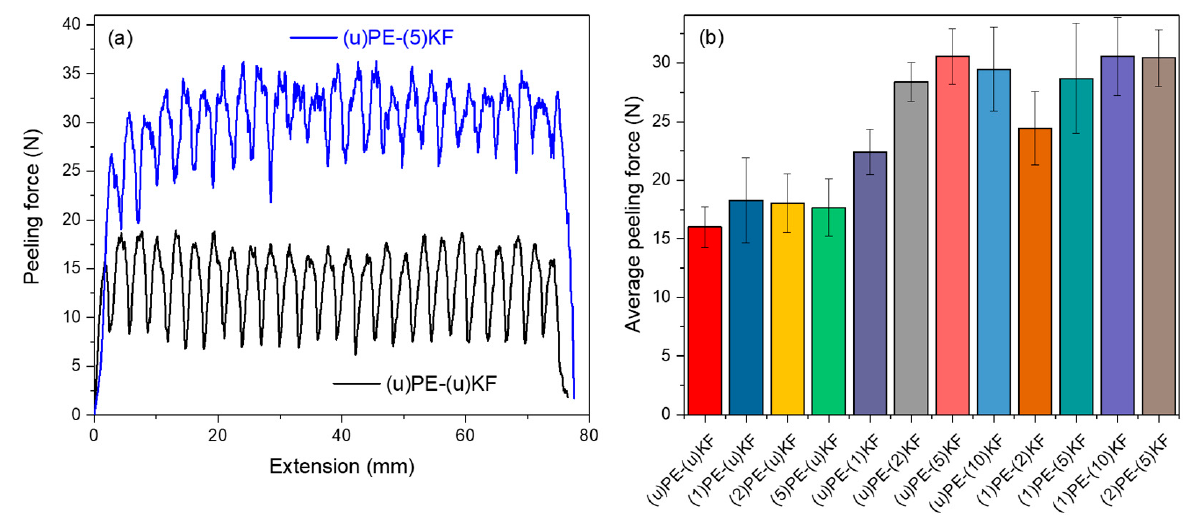
Figure 9. Peel-off force versus extension curves for a sample without treatment and a sample with PPTA treated for 5 min ( a ); and average peel-off force for different samples ( b ). PE: UHMWPE film. KF: PPTA fabric. U: untreated. The numbers in the brackets indicate treatment time in minutes.